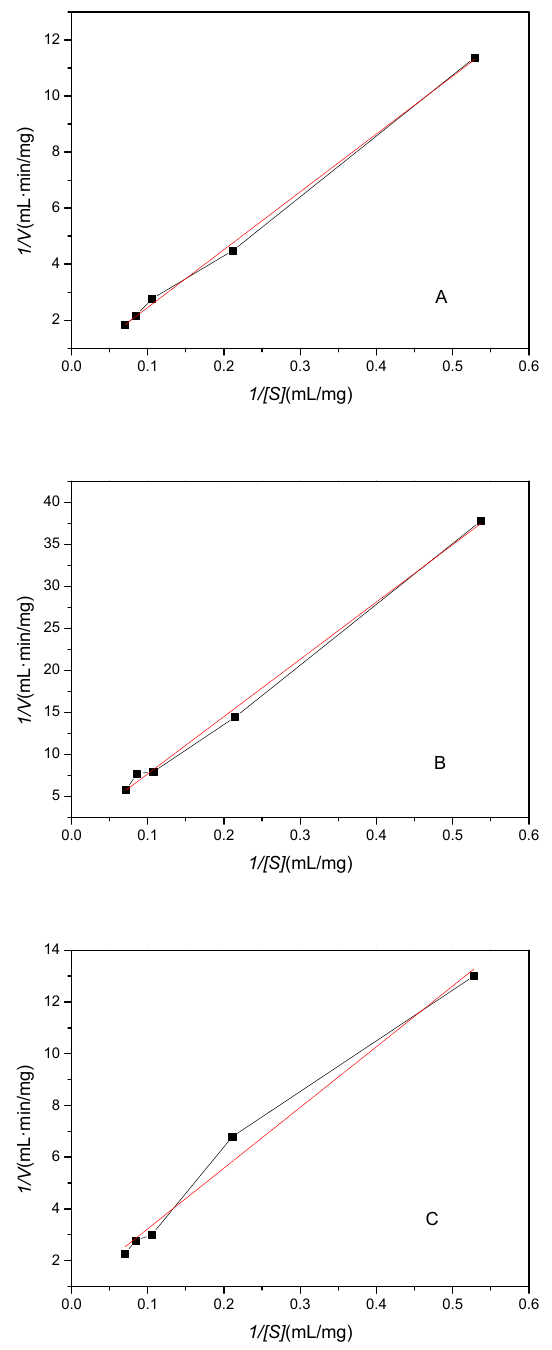
Figure 5. Enzymatic kinetic fitting curves for different substrates ( A ) cephalexin, ( B ) cefradin, ( C ) cefadroxil).